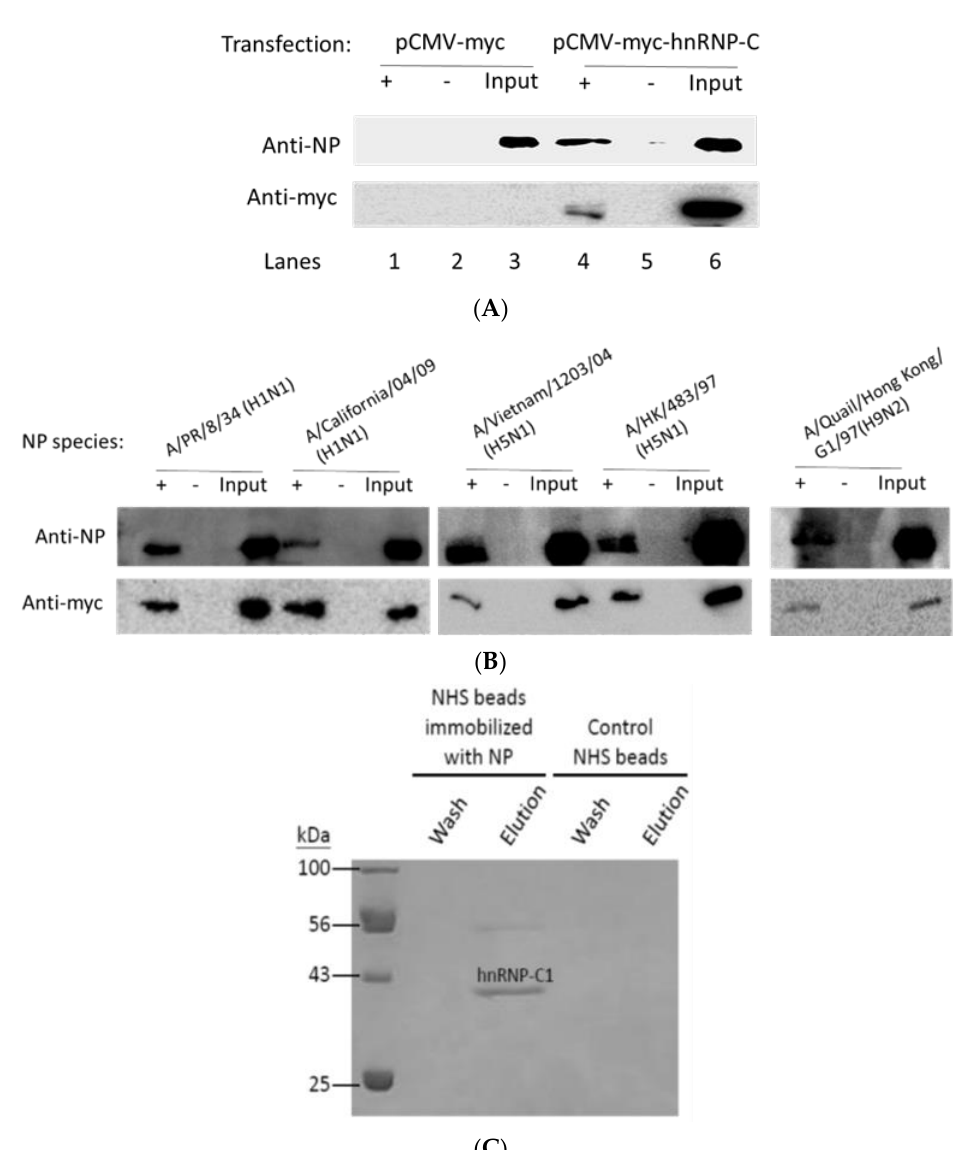
Figure 1. ( A ) HEK293T cells were transfected with myc-hnRNP-C and infected with A/WSN/1933 (H1N1) virus at MOI 0.05 for 24 h. NP from infection was co-immunoprecipitated by myc-tagged hnRNP-C (lane 4) but not by empty vector control (lane 1) or antibody controls (lanes 2 and 5). Inputs were loaded (0.2× volume) as lanes 3 and 6 in the figure; ( B ) HEK293T cells were co-transfected with myc-hnRNP-C and various untagged NP species in pcDNA3. hnRNP-C was immunoprecipitated by anti-myc and NP was detected using NP anti-serum. NP species used in this experiment include A/PR/8/34(H1N1), A/California/04/09(H1N1), A/Vietnam/1203/04(H5N1), A/Hong Kong/483/97(H5N1), and A/Quail/Hong Kong/G1/97(H9N2). ( A , B ) +: myc antibody added; − : negative controls without myc antibody; ( C ) purified H5 NP was immobilized on NHS-Sepharose, and purified hnRNP-C1 was allowed to pass through the beads. After washing, hnRNP-C1 could be eluted by 2 M NaCl, indicating in vitro binding between the two proteins. No hnRNP-C1 could be eluted from control NHS beads (activated – inactivated beads without NP), ruling out the possibility of non-specific binding.